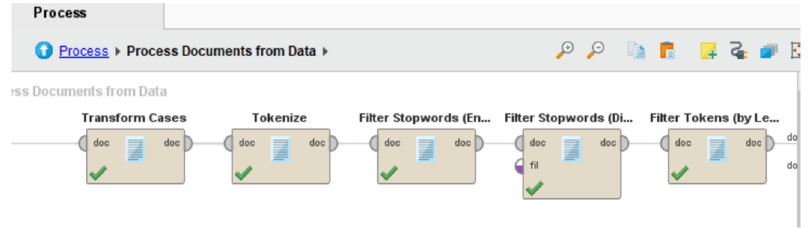
Figure 6. Pre-processing stage.